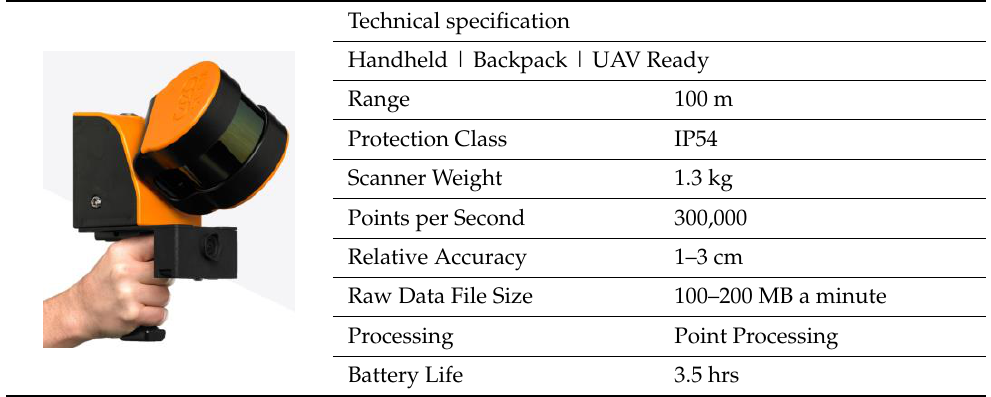
Table 2. Technical specification of GeoSLAM Zeb-Horizon. (https://microsolresources.com/wp- content/uploads/2019/06/GeoSLAM-Family-Brochure.pdf, accessed on 2 December 2021).